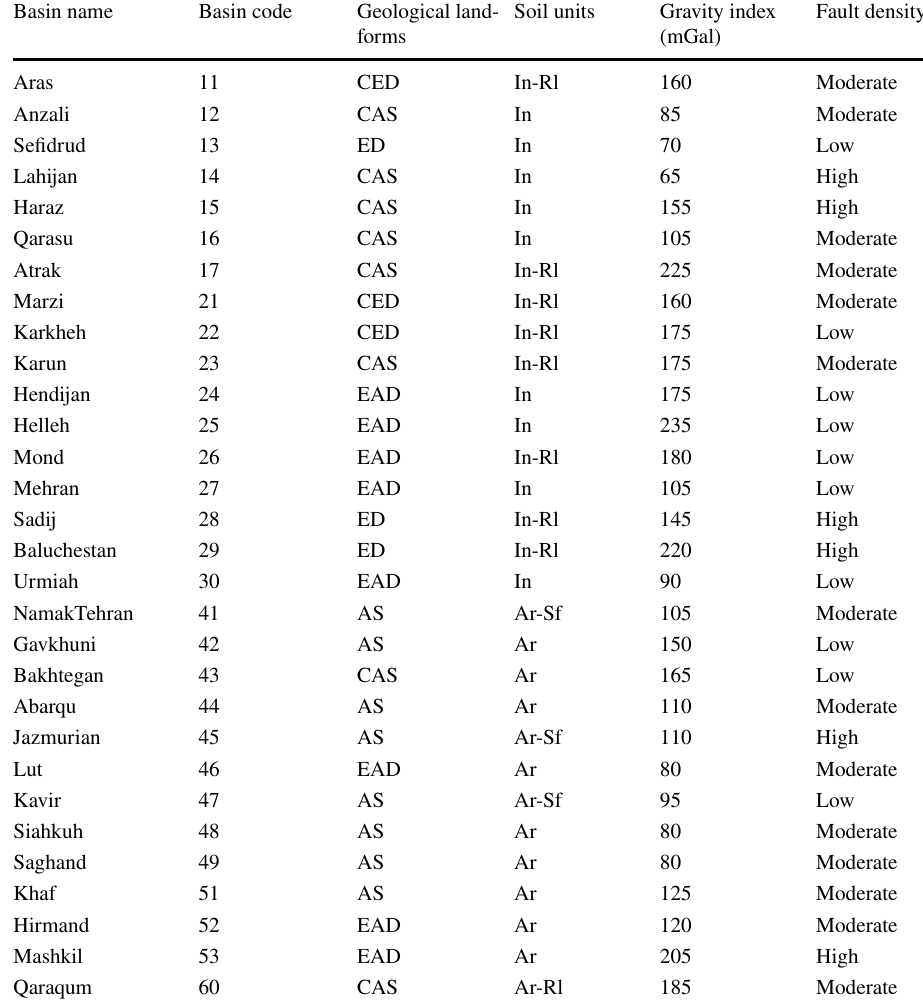
Table 6 Inventory of environmental variables of 30 major hydrological basins in Iran, including geological landforms, soil units, gravity index, and fault